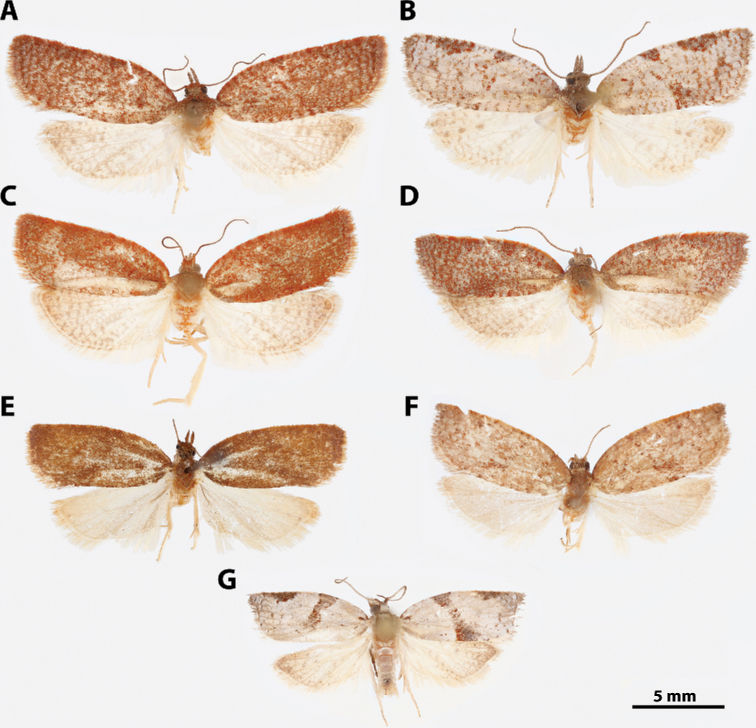
Claduncariamesosignaria group adults. ACla.
mesosignaria holotype ♀, Dominican Republic (CMNH) BCla.
mesosignaria ♂ (holotype of Argyrotaeniathamaluncus syn. nov.), Dominican Republic (CMNH) CCla.
minisignaria holotype ♀, Dominican Republic (CMNH) DCla.
minisignaria ♂, Dominican Republic (CMNH) ECla.
chalarostium comb. nov., stat. nov. holotype ♀ (erroneously affixed with Argyrotaenia
jamaicana paratype label), Jamaica (CMNH) FCla.
rufochlaena holotype ♂, Jamaica (CMNH) GCla.
taino sp. nov. holotype ♂, Dominican Republic (CMNH).